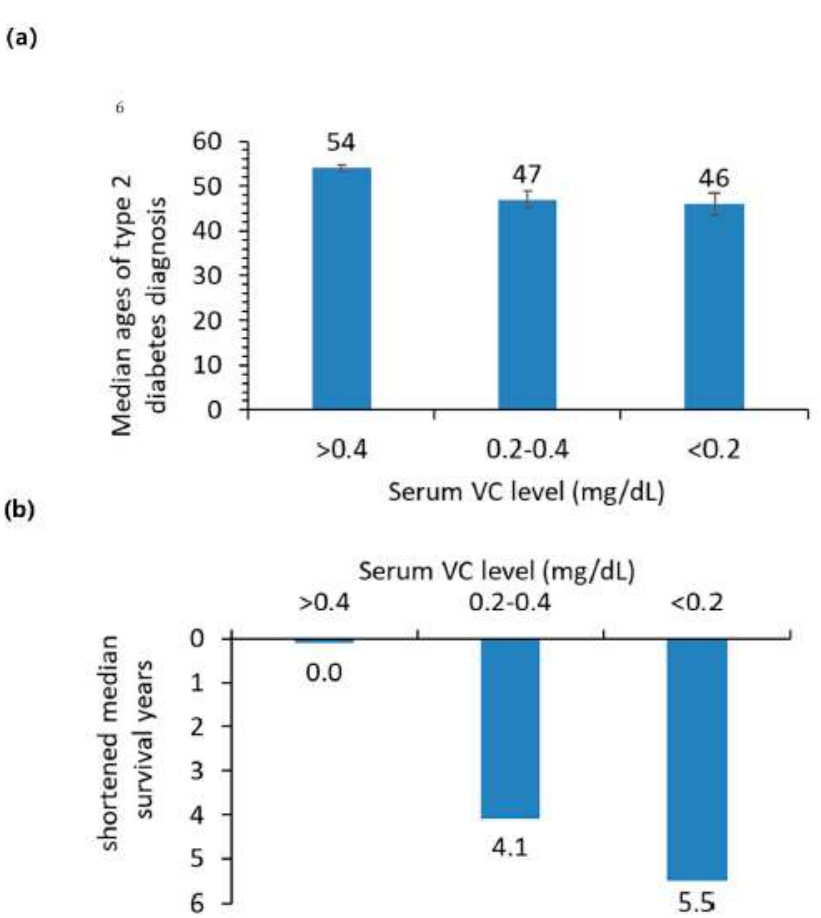
Figure 3. ( a ), median ages of type 2 diabetes diagnosis in US adults with normal, low, and deficient serum VC (>0.4, 0.4–0.2, and <0.2 mg/dL). Vertical bars are standard errors and bar top labels are age years. ( b ), shortened median survivor years of type 2 diabetic US adults with low and deficient serum VC from those with normal serum VC. Shortened 25th percentile survival years were 6.9 and 13.4 years and the 75th percentile survival years were 4.3 and 2.2 years respectively. Table 5. HRs 1 of all-cause mortality of adults with total VC intake below the EAR, no VC supplement, with low and deficient serum VC for US adults with and without